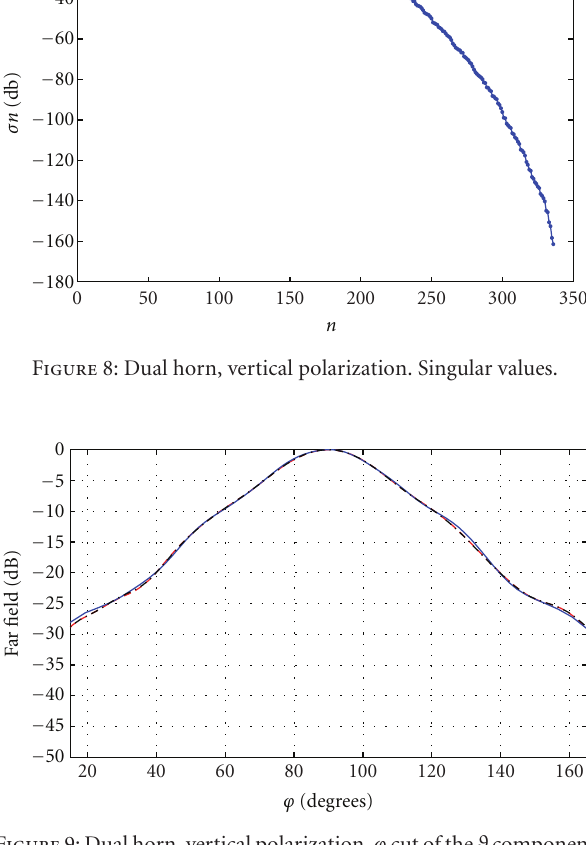
Figure 9: Dual horn, vertical polarization. ϕ cut of the ϑ component of the far field. Blue solid line: proposed approach. Red dashed line: approach in [7, 8]. Black dash-dot line: standard, probe compensated NF-FF transformation.